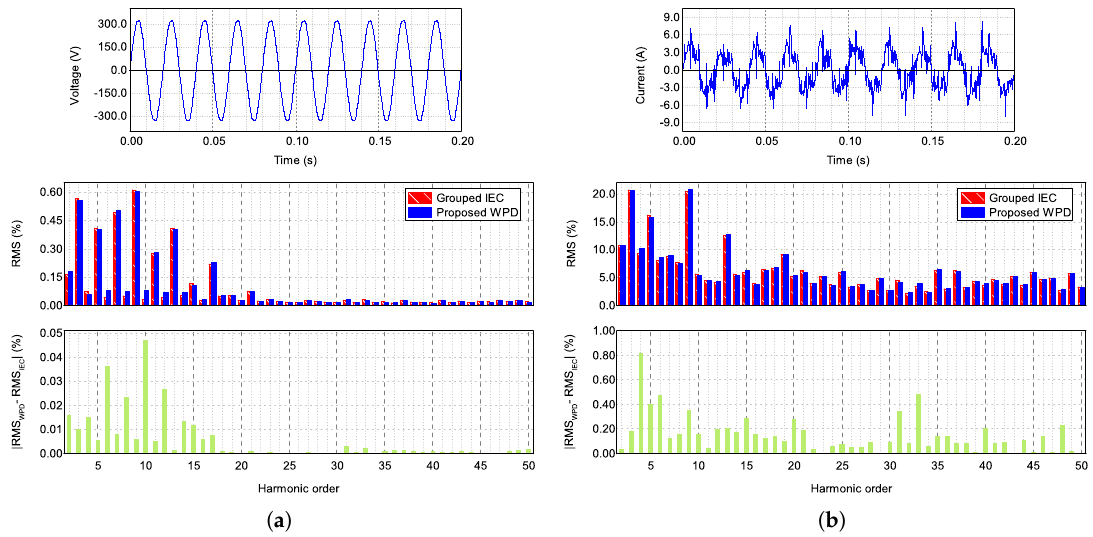
Figure 10. Analysis of real waveforms with a stationary ( a ) and non-stationary ( b ) character. The top graphs show the waveforms in the time domain, the middle graphs the harmonic content, and the bottom graphs the absolute difference between the proposed method and the IEC